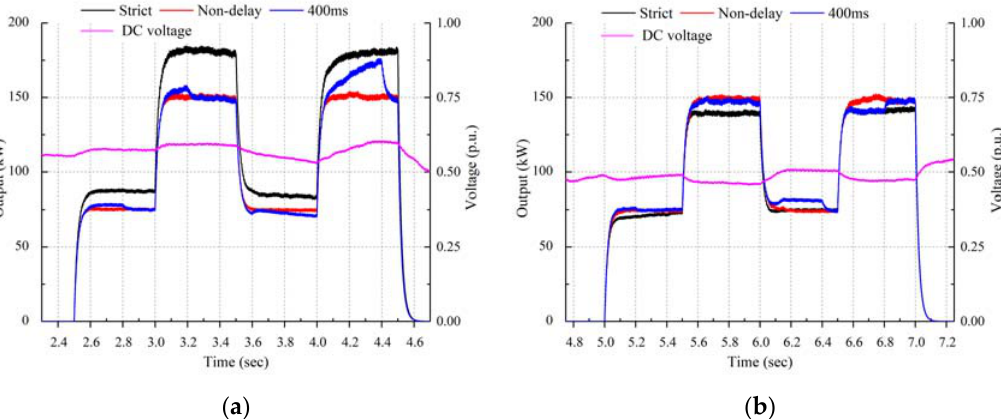
Figure 10. ESS states for central topology with 200 ms interval ( a ) extracted power quantity in the discharging section (2.5 to 4.5 s); ( b ) absorbed power quantity in the charging section (5 to 7 s). Energies 2020 , 13 , x FOR PEER REVIEW